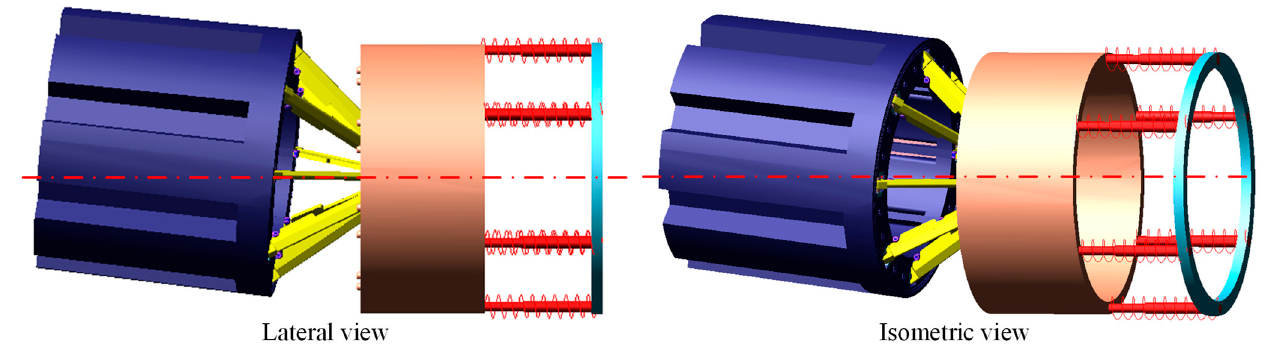
Figure 13. The docking mechanism in the simulation environment.